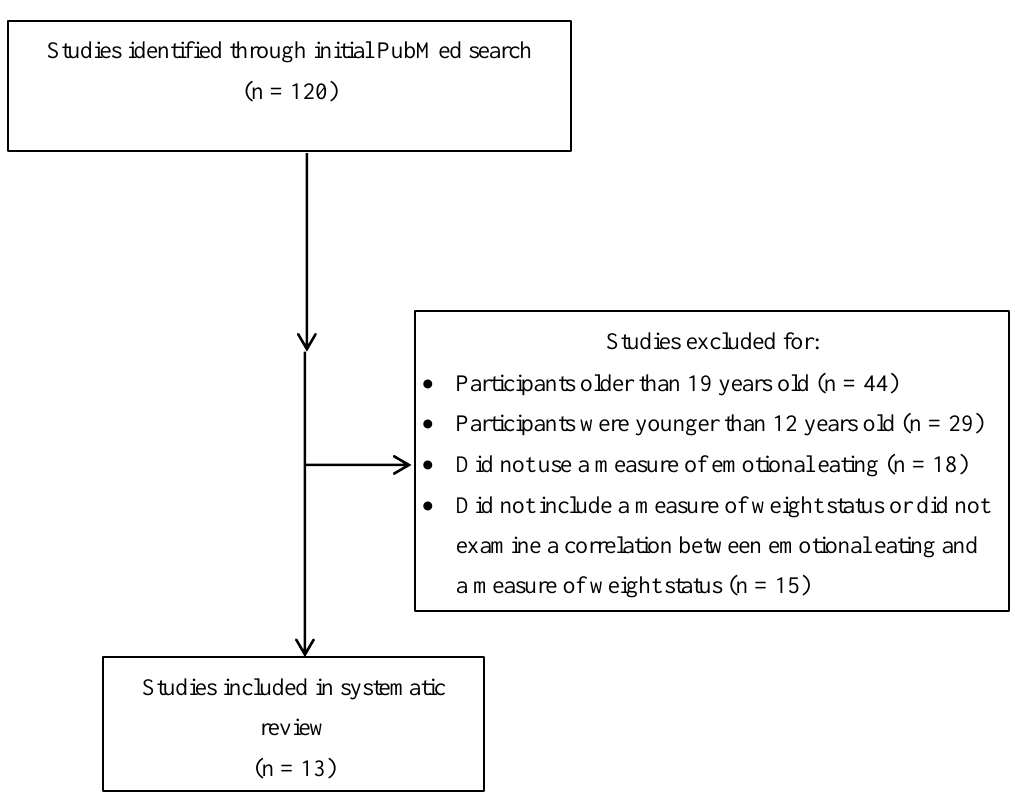
Figure 1. Flow Diagram of Article Selection.